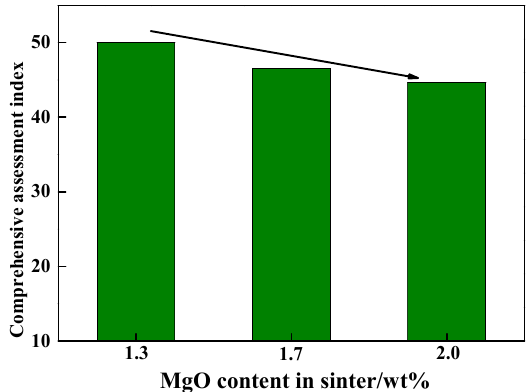
Figure 24. Comprehensive assessment index of different MgO content sinter.